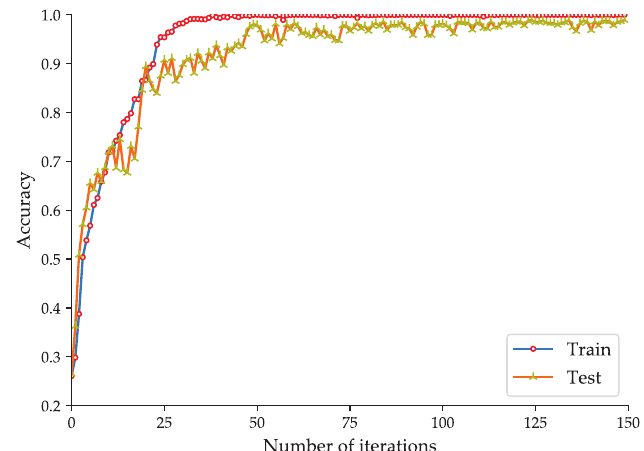
Figure 5. Accuracy curve of the fault diagnosis model based on the improved 2D LeNet-5